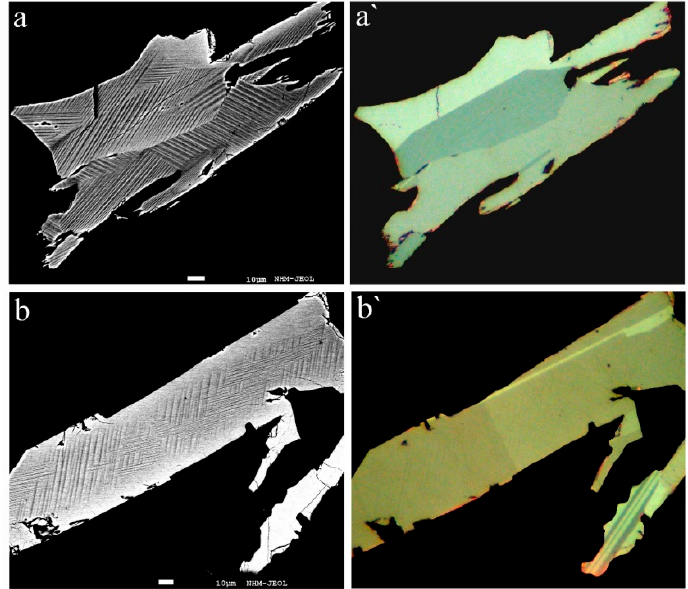
Figure 2. Representative backscattered electron images and corresponding reflected-light photographs (crossed polars) of two aggregates ( a , b ) showing mixed exsolution lamellae of the Tl-richest rathite (bright grey phase, rath9 in Table 1; 11.78 wt% Tl) and a possibly new, still Tl-richer species, “SR” (dark grey phase, rath10 in Table 1; 13.25 wt% Tl). Note that the small fragment in the ( b’ ) optical image shows twin lamellae.